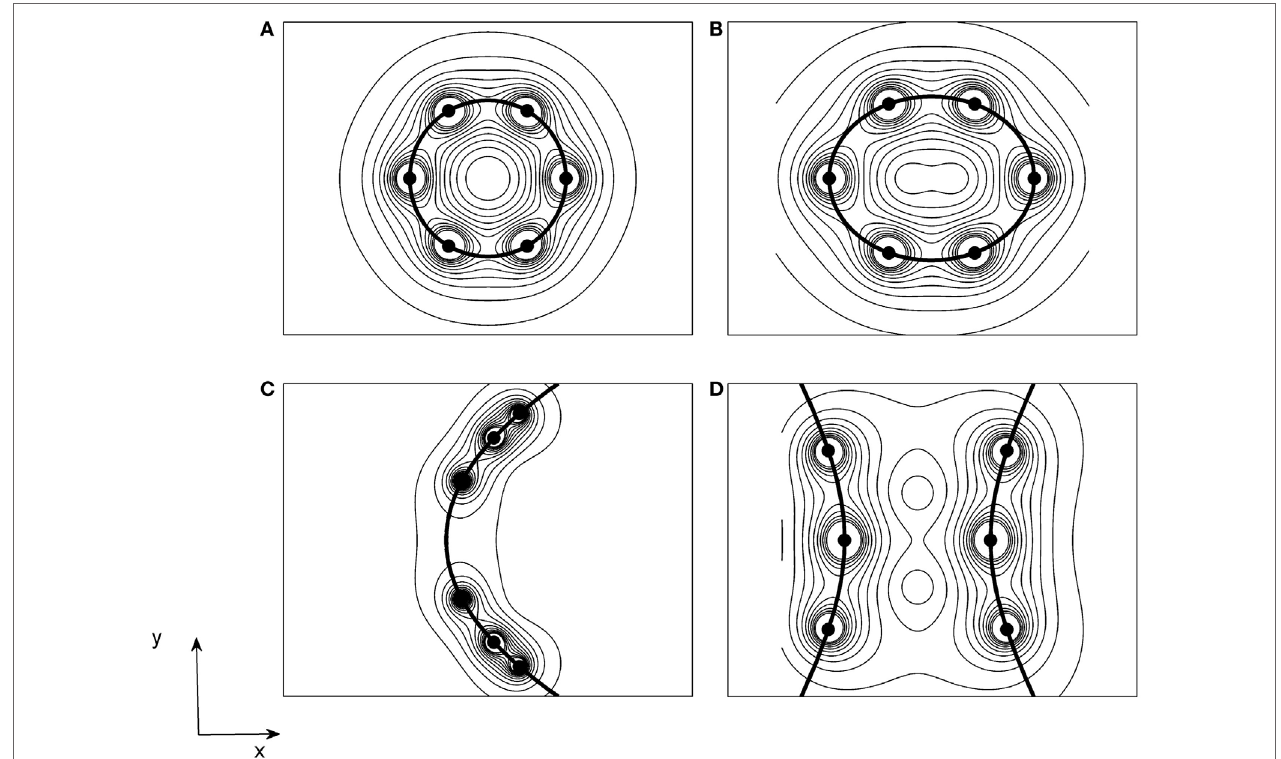
FigUre 3 | Two-dimensional spatial patterns of the electric field intensity induced in an homogeneous, isotropic, and linear medium for electrode configurations with (a) circular; (B) elliptical; (c) parabolic; and (D) hyperbolic shapes, which are defined in Figure 1B [courtesy of Pupo et al.